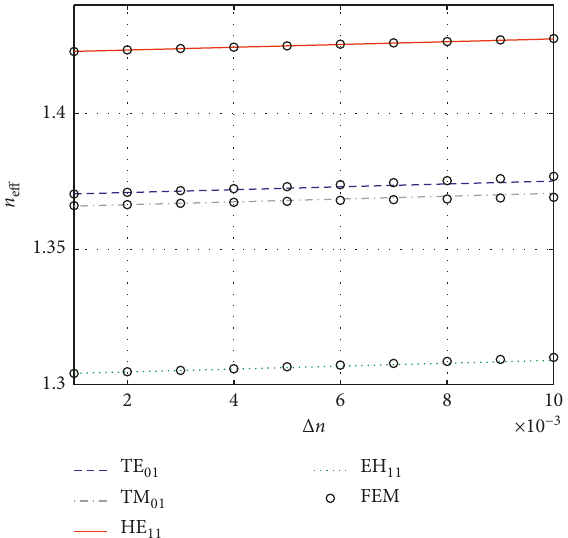
Figure 2: Effective refractive index of the perturbed optical fiber in Figure 1(b) for the four propagation modes versus Δ n obtained by our HFHE formulation (lines) and calculated by the vector FEM